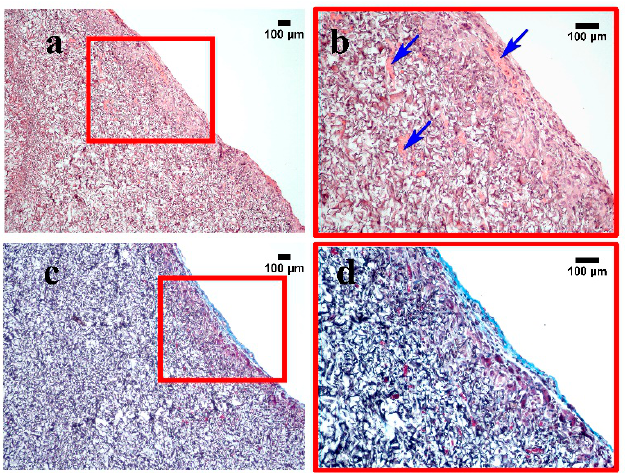
Figure 6. Representative images of the gelatin sponge on the 21 day of subcutaneous implantation: ( a , b ) hematoxylin and eosin staining; ( c , d ) Masson staining. Scale bar = 100 µ m. Blue arrows—blood capillaries.